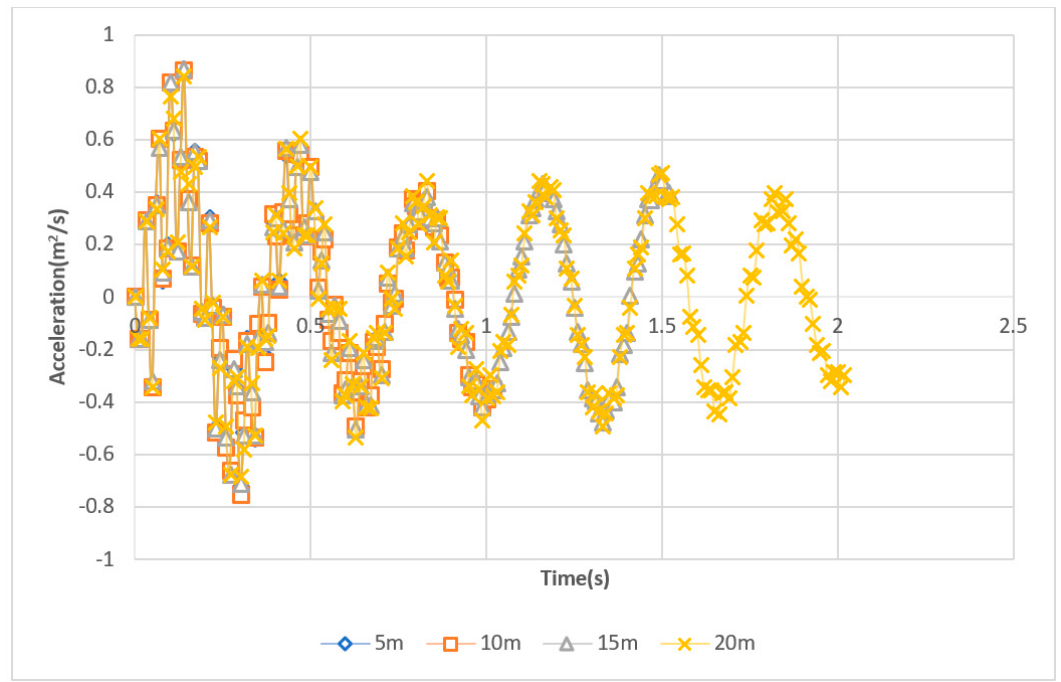
Figure 20. Right front axle acceleration history when approaching the bridge at 10 m/s.